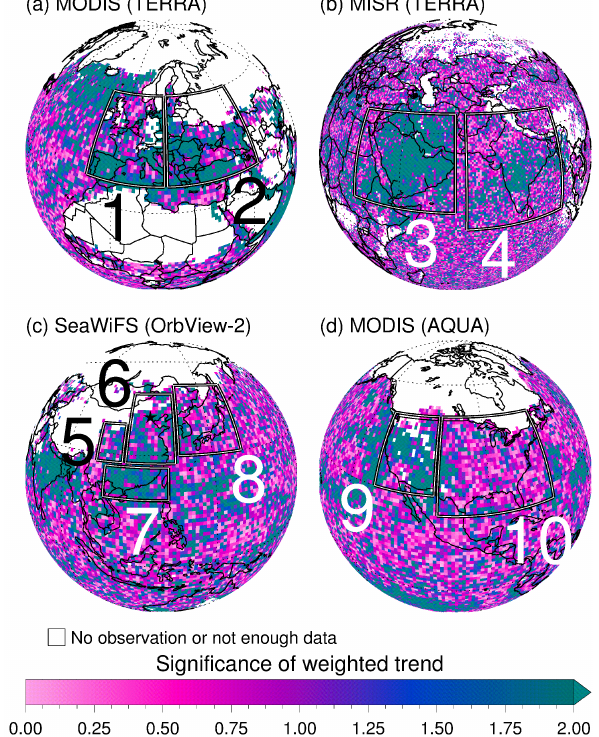
Figure 9. Plots of the significance of weighted trends derived from (a) MODIS (Terra) AOT (550nm), (b) MISR (Terra) AOT (558nm), (c) SeaWiFS (OrbView-2) AOT (510nm), and (d) MODIS (Aqua) AOT (550nm). The significance is defined as (cid:12) (cid:12) . (cid:12) (cid:12) B g σ B B g and σ B are the weighted trend and its stan- (cid:12) (cid:12) , where g g dard deviation. A significance larger than 2 means that the trend is statistically significant within a 95% confidence level.